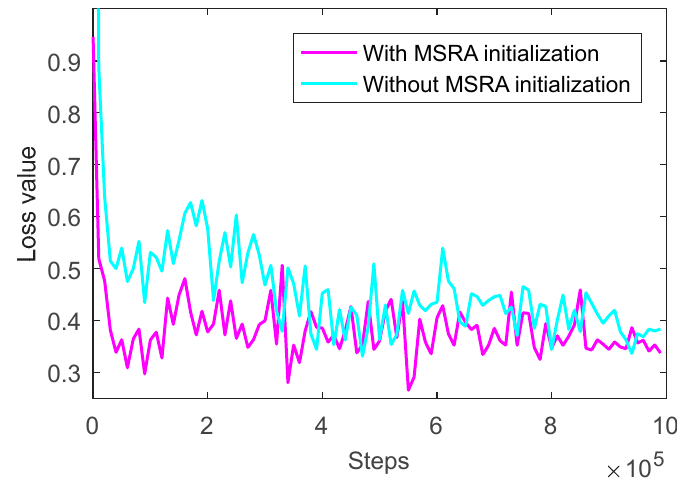
Figure 10. Loss value of CNN with MSRA initialization for weights using the training set.